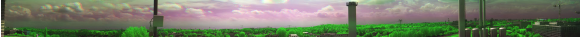
Figure 9. Channel alignment using phase correlation (upper image), matching with ORB features (middle image), enhanced correlation coefficient (ECC) optimization (lower image)